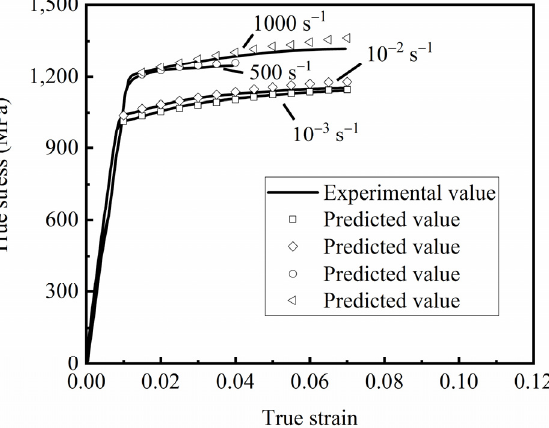
Figure 7. Relationship between experimental data and the Johnson–Cook model under different strain rates.